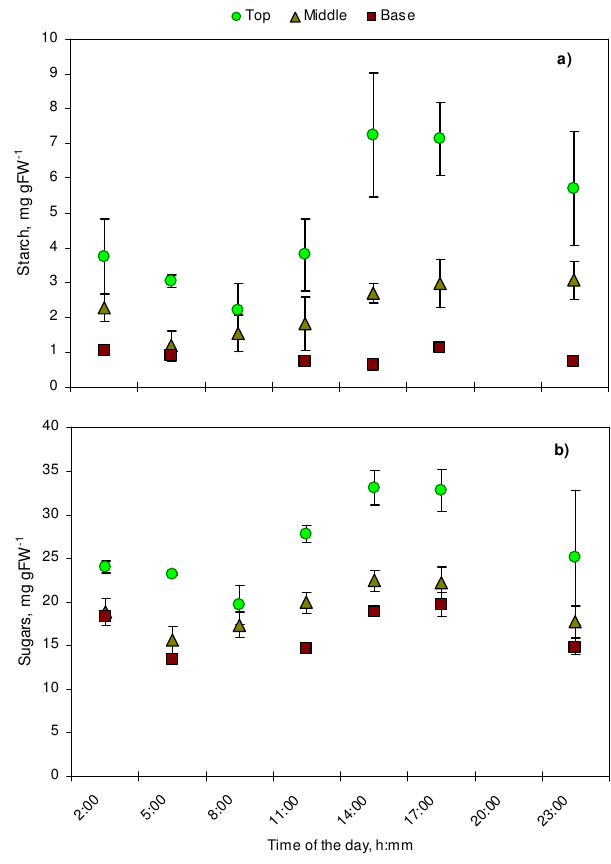
Fig. 3. 24-h time-course of (a) leaf starch content and (b) leaf sugars content (each point is a sum of sucrose, fructose and glucose) in the top, middle and base crown leaves of beech trees. Bars represent the standard error of mean ( n =